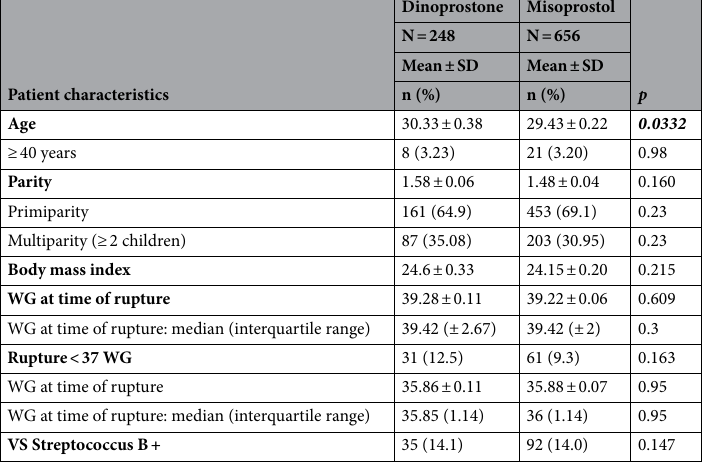
Table 1. Patient characteristics. VS = Vaginal swab; WG = weeks of gestation. Significant values are in bolditalics.